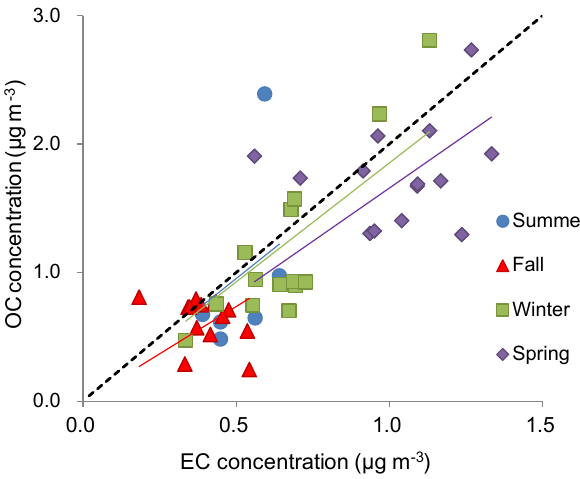
Figure 6. Cluster analysis of 72h HYSPLIT-WRF wind back tra- jectories arriving every 12h for each sampling day for all seasons. Color represents each of the five clusters generated by the